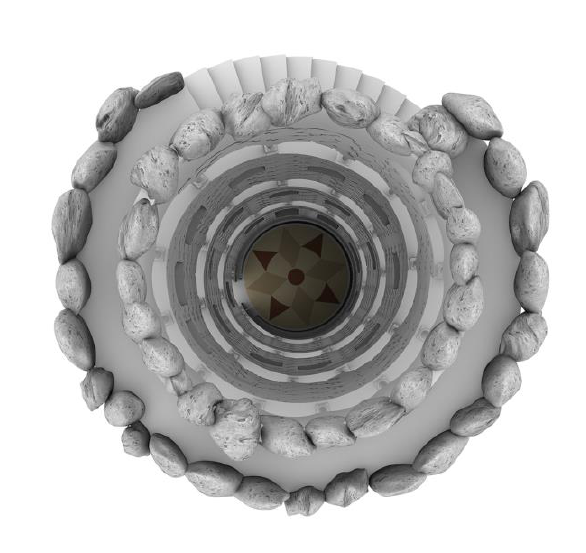
Figure 15 . The Quinta da Regaleira in Sintra, the Poço Iniciatico , digital model, bird’s eye view.